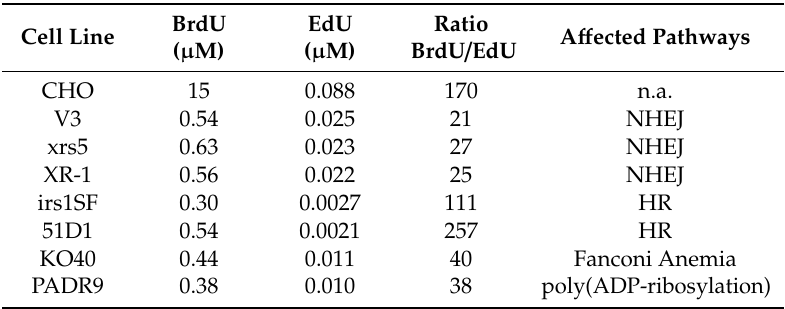
Figure 5. Cell survival curves against BrdU or EdU in DNA repair-deficient cells in the nucleotide and nucleoside free media. Closed circles indicate BrdU treatments and open circles indicate EdU treatments. Error bars represent the standard error of the mean of three independent experiments. Table 1. IC 50 values of BrdU and EdU for DNA repair-deficient cells.